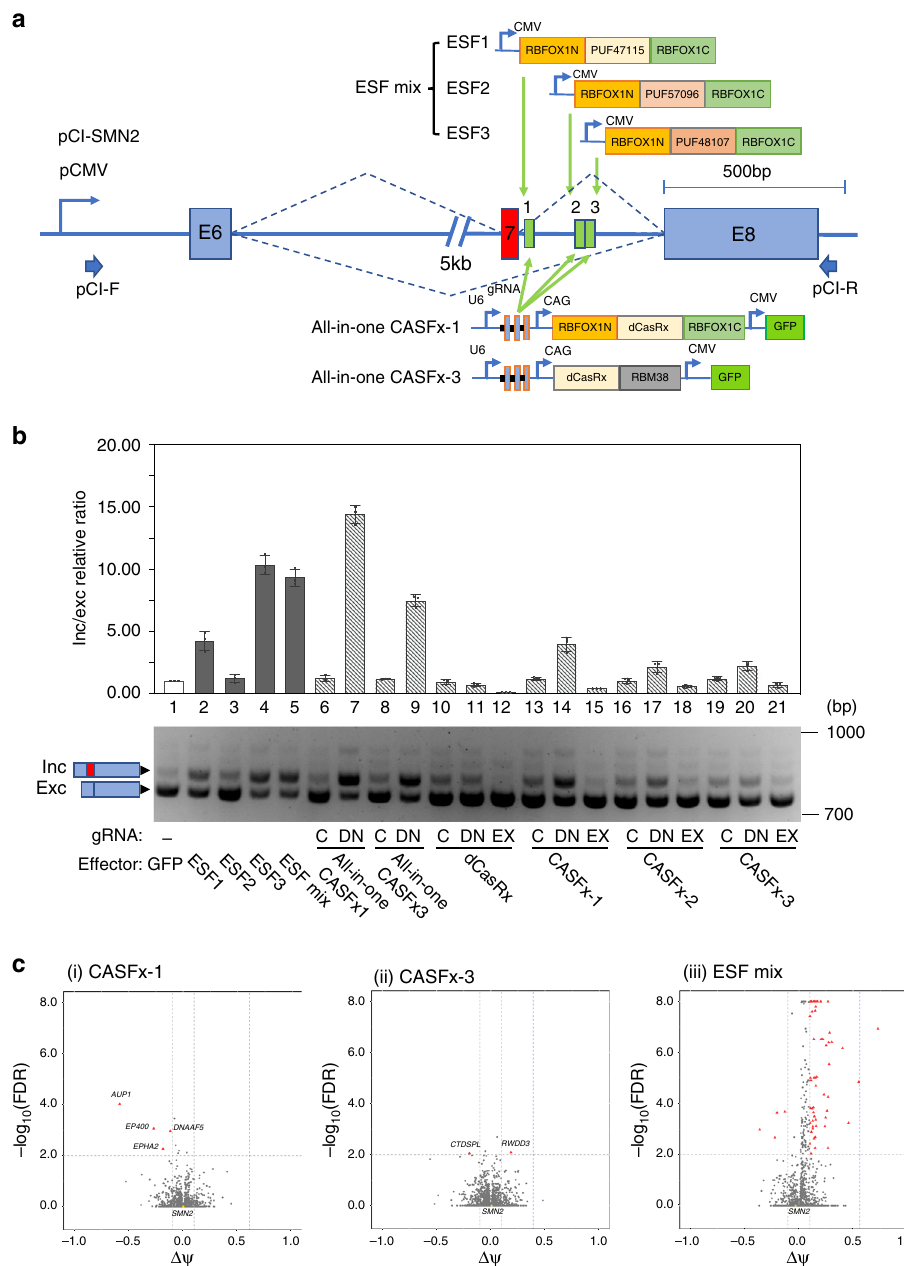
Fig. 4 Ef fi ciency and speci fi city comparison of exon activation induced by CASFx and PUF-ESF. a Schematic of the three PUF-based engineered splicing factors (PUF-ESFs), two all-in-one CASFx-1 plasmids and the target sites of gRNA 1-3 on the SMN2 minigene. ESF mix represents a pool of three PUF-ESF constructs. b Upper panel shows inclusion/exclusion (inc/exc) ratio fold-changes assayed by qRT-PCR on SMN2 minigene transcripts in transfected cells with respect to GFP control (set to 1). Data are represented as mean ± SD ( n = 3). Lower panel shows a gel image of semi-quantitative splicing RT-PCR of SMN2 minigene transcripts in cells transfected with indicated constructs. c Plots showing changes in percentage spliced-in ( ΔΨ ) and rMATS-computed Benjamini-Hochberg False Discovery Rate (FDR) of cassette exons in cells transfected with indicated constructs compared with GFP control, as determined by RNA-seq ( n = 2 biological replicates per sample). Exons with signi fi cant changes (| ΔΨ | ≥ 0.1 and FDR ≤ 0.01) are colored in red. ΔΨ of SMN2 -minigene was calculated based on the RNA-seq reads matching with minigene-speci fi c sequences and is indicated as blue vertical dotted line. Uncropped gel images and qRT-PCR values are included in the Source Data fi